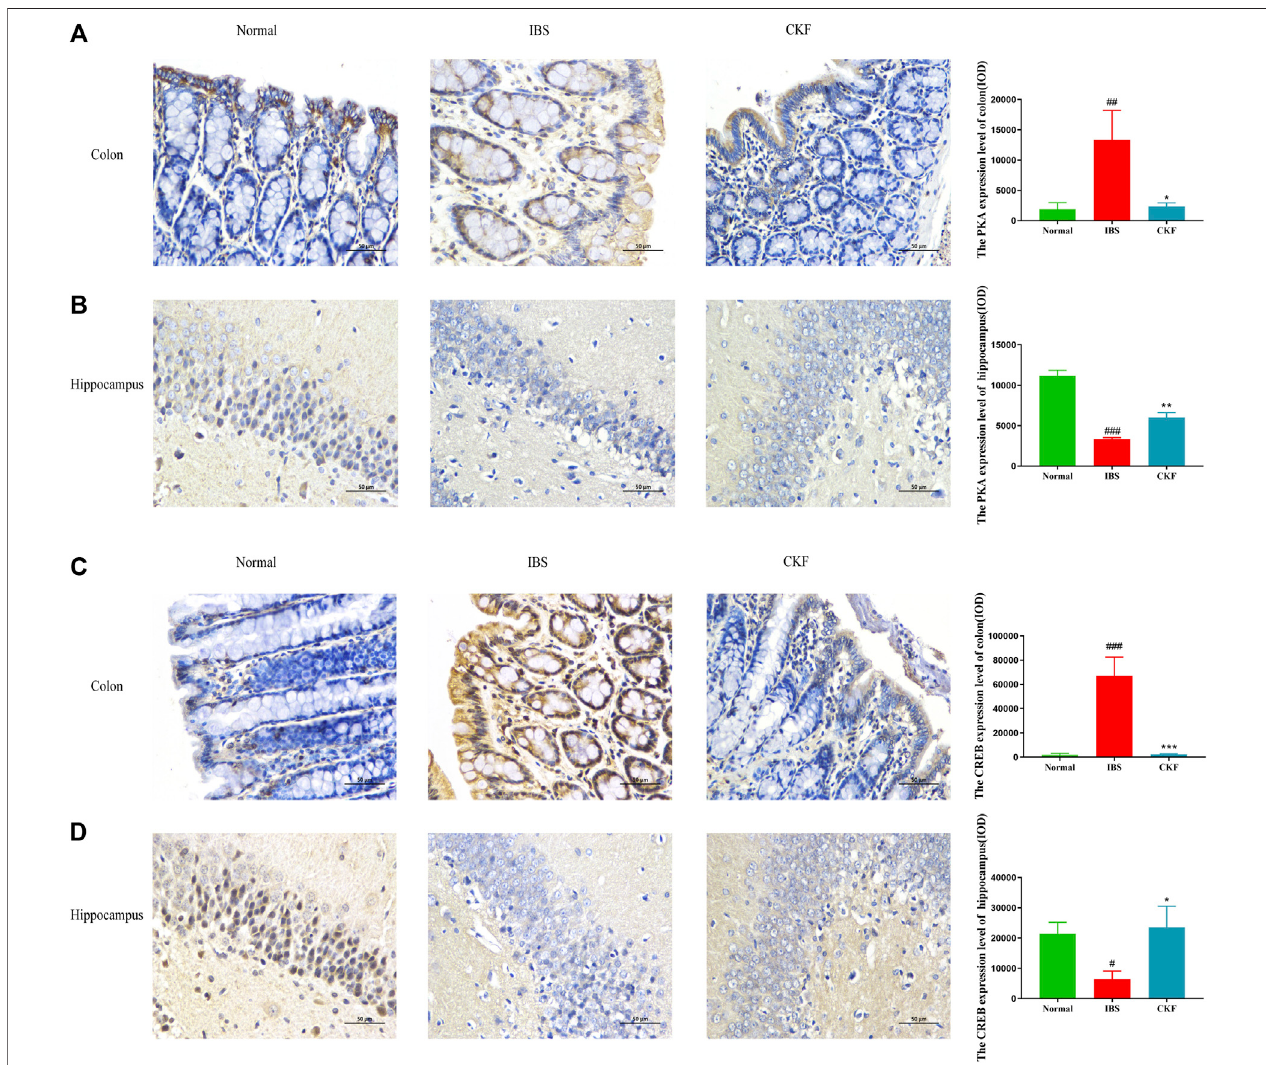
FIGURE 6 | Immunohistochemical staining for the colon and hippocampal (A,B) PKA and (C,D) CREB. Values are presented as the means ± SD ( n = 3). ### p < 0.001 as compared to Normal,* p < 0.05, ** p < 0.01 and *** p < 0.001 as compared to IBS.